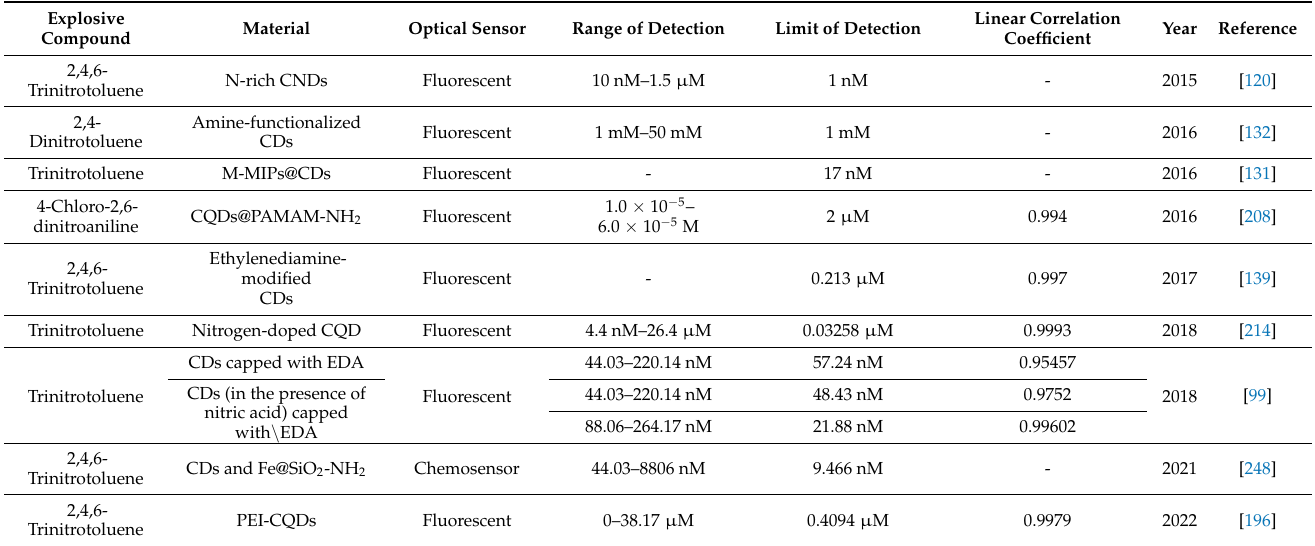
Table 13. Summary of the developed optical sensors for explosive compound